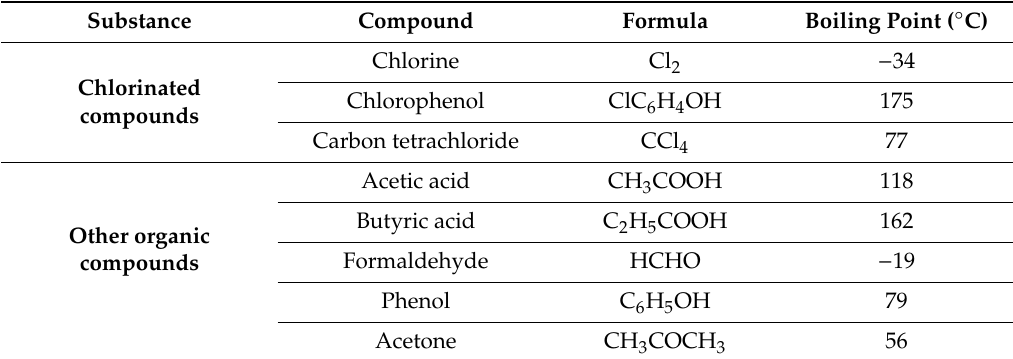
Table 2. Examples of malodorous substances concentrating at various points in a system.